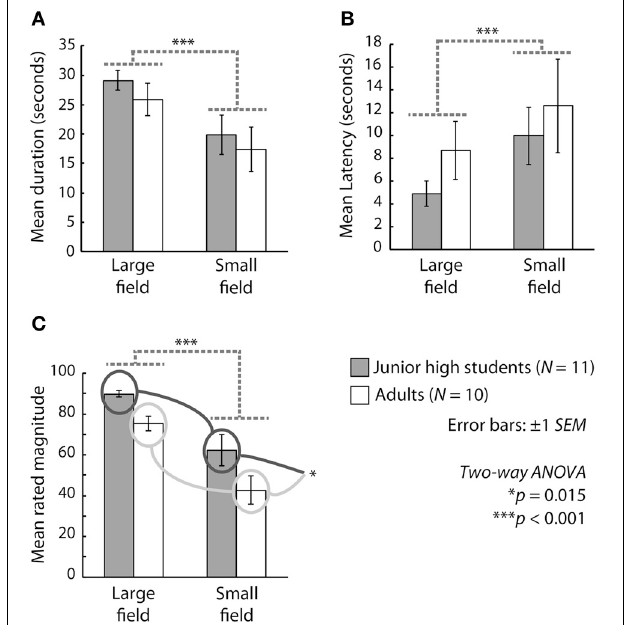
FIGURE 1 | Mean (A) duration, (B) latency, and (C) magnitude of vection across participants. Gray and white bars show the results for junior high school students and adults, respectively. The two bars on the left side and those on the right side of each graph indicate results under the large-field and the small-field conditions, respectively. Error bars represent ± 1